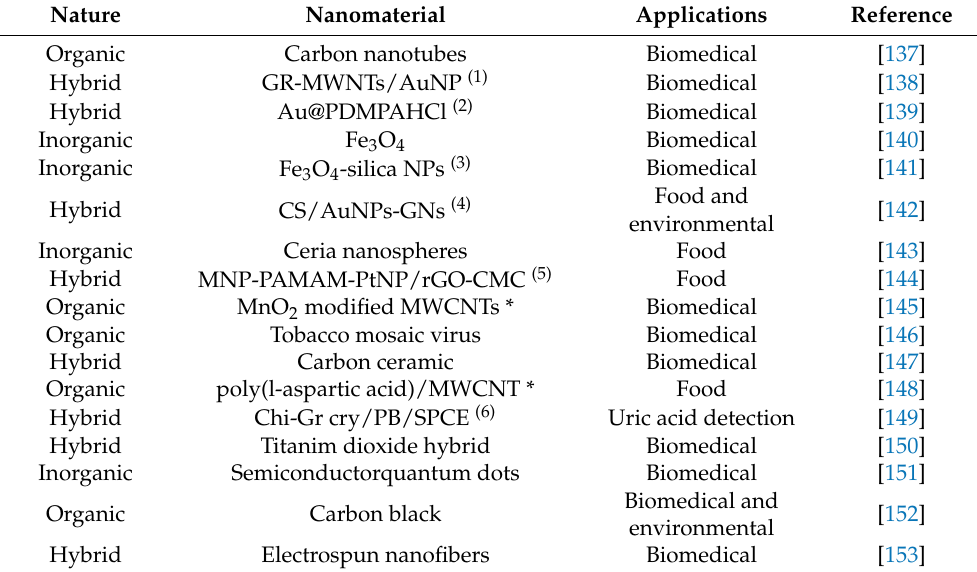
Table 1. Nanomaterial-based biosensors for different